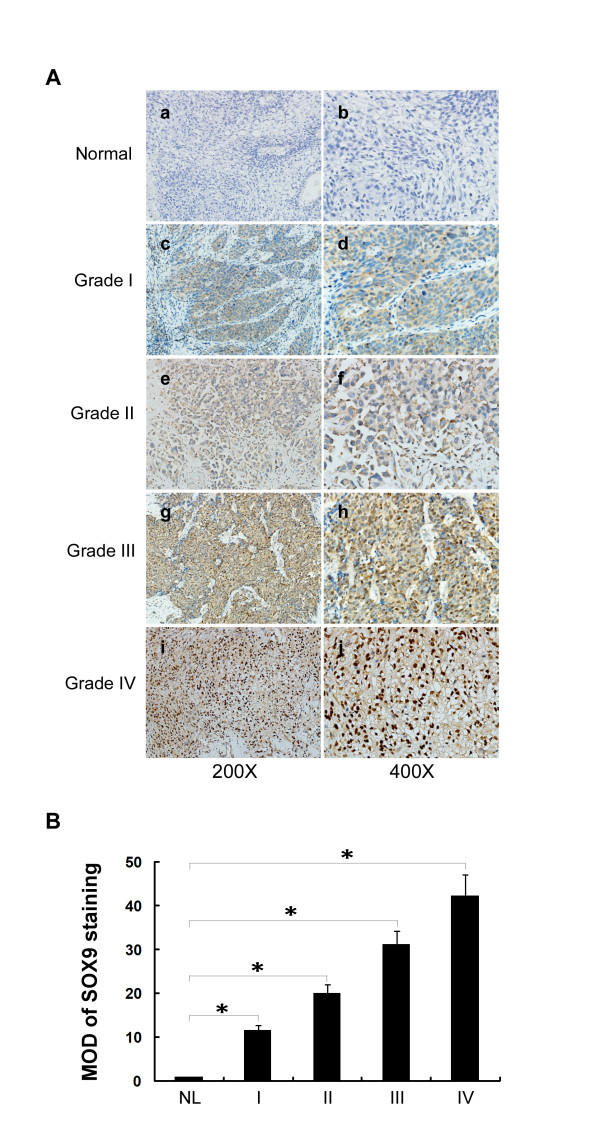
Immunohistochemical analysis of SOX9 expression in normal lung tissue and primary NSCLC. A, thin sections of paraffin-embedded specimens of a total of 2 normal lung tissues and 142 primary NSCLC specimens including AJCC grade I to IV NSCLC samples were stained by immunohistochemistry using an anti-SOX9 antibody. a and b, normal lung tissue; c and d, AJCC grade I NSCLC; e and f, AJCC grade II NSCLC; g and h, AJCC grade III NSCLC; i and j, AJCC grade IV. Amplification, 200 (a, c, e, g, and i) and 400 (b, d, f, h and j). Immunohistochemical analyses were done two independent times on each of the samples with similar results. B, statistical quantification of the average mean absorbance of SOX9 staining between normal lung tissues (4 cases) and NSCLC specimens of different AJCC grades (30 random cases per grade). Average mean absorbance of SOX9 staining increases as NSCLC progresses to higher grades. *, P < 0.01.